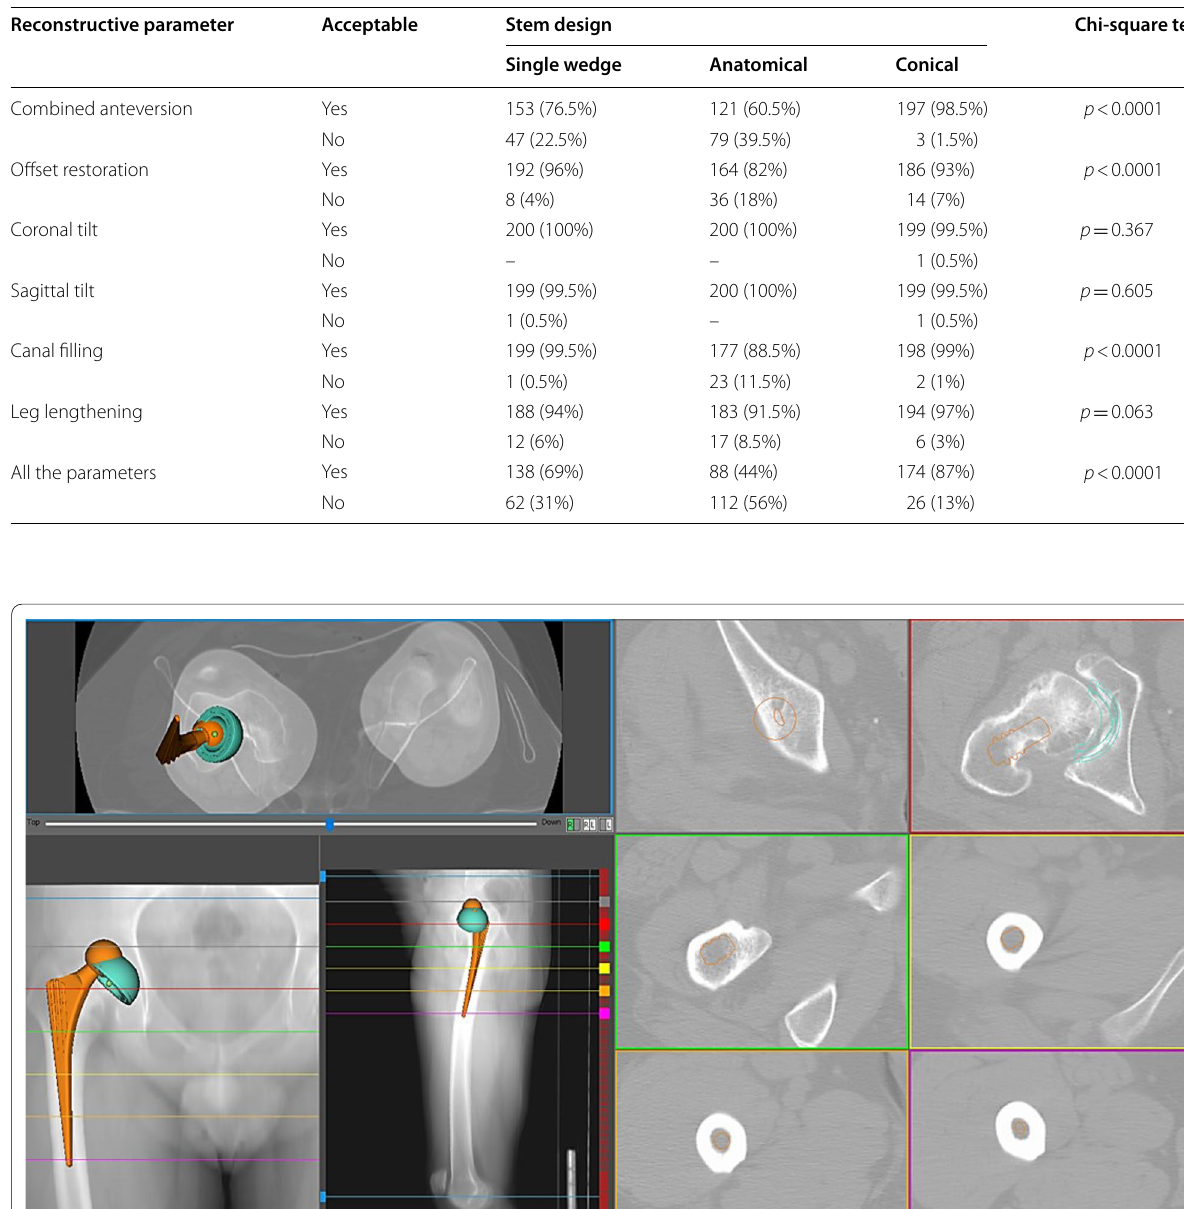
Table 2 The percentage of acceptable implants for every stem design (every single parameter was evaluated; the last row shows the percentages of acceptable implants that matched all six criteria)